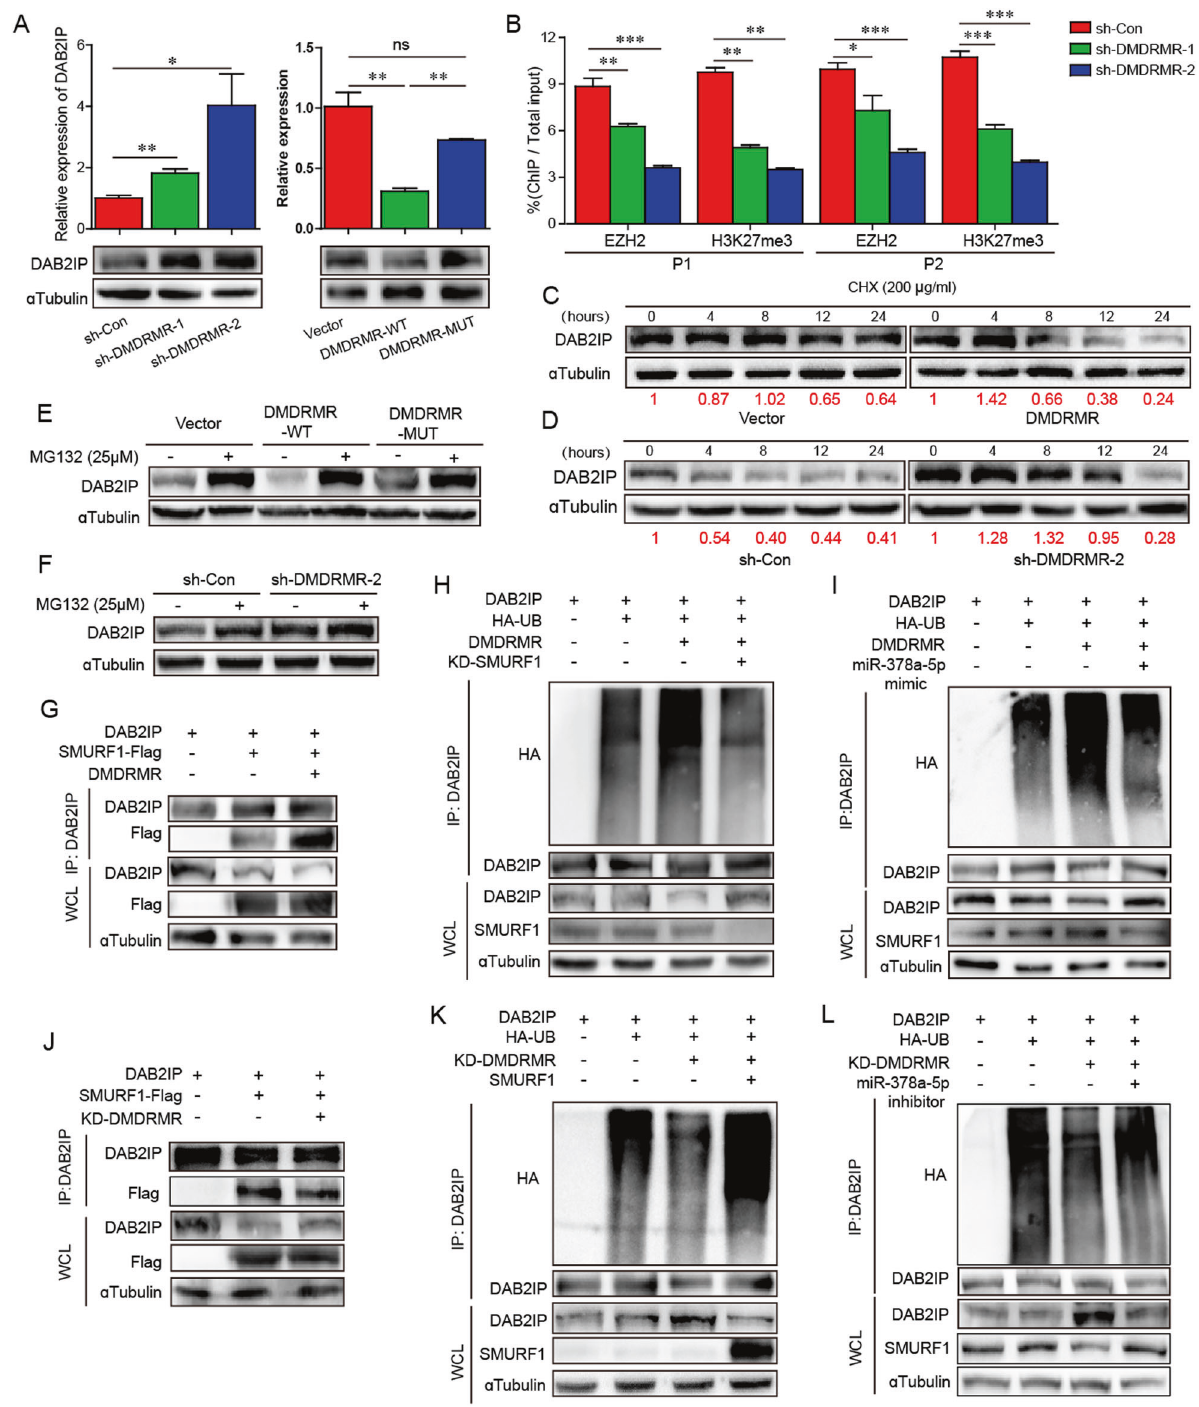
Fig. 6 DMDRMR represses DAB2IP expression through its ceRNA. A The qRT-PCR (top) and immunoblot (bottom) analysis of DAB2IP in DMDRMR KD 786-O cells (left) and in DMDRMR -WT and MUT OE 769-P cells (right). B ChIP qRT-PCR analysis showing the binding ef fi ciencies of EZH2 and H3K27me3 to the two regions of DAB2IP promoter in DMDRMR KD 786-O cells. P1, the fi rst region of DAB2IP promoter; P2, the second region of DAB2IP promoter. C , D Immunoblot of DAB2IP in the DMDRMR OE 769-P cells ( C ) and KD 786-O ( D ) cells treated with cycloheximide (CHX) for indicated times. The densitometry analysis showing the relative DAB2IP expression levels that normalized to the reference protein α Tubulin (Red numbers). E , F Immunoblot of DAB2IP in the DMDRMR -WT and MUT OE 769-P cells ( E ) and DMDRMR KD 786-O cells ( F ) treated with MG132 for 10 h. G , J Immunoprecipitation showing the association between DAB2IP and SMURF1 in DMDRMR OE 769-P cells ( G ) and KD 786-O cells ( J ). H , K Immunoprecipitation showing the associations between DAB2IP and HA-tagged ubiquitin (HA-UB) in SMURF1 KD with DMDRMR OE 293T cells ( H ) and in DMDRMR KD with SMURF1 OE 293T cells ( K ). I , L Immunoprecipitation showing the associations between DAB2IP and HA-UB in DMDRMRM OE transfected with miR-378a-5p mimic 293 T cells ( I ) and in DMDRMR KD transfected with miR-378a-5p inhibitor 293T cells ( L ). The results are presented as mean ± SEM. * p < 0.05, ** p < 0.01, and *** p < 0.001.